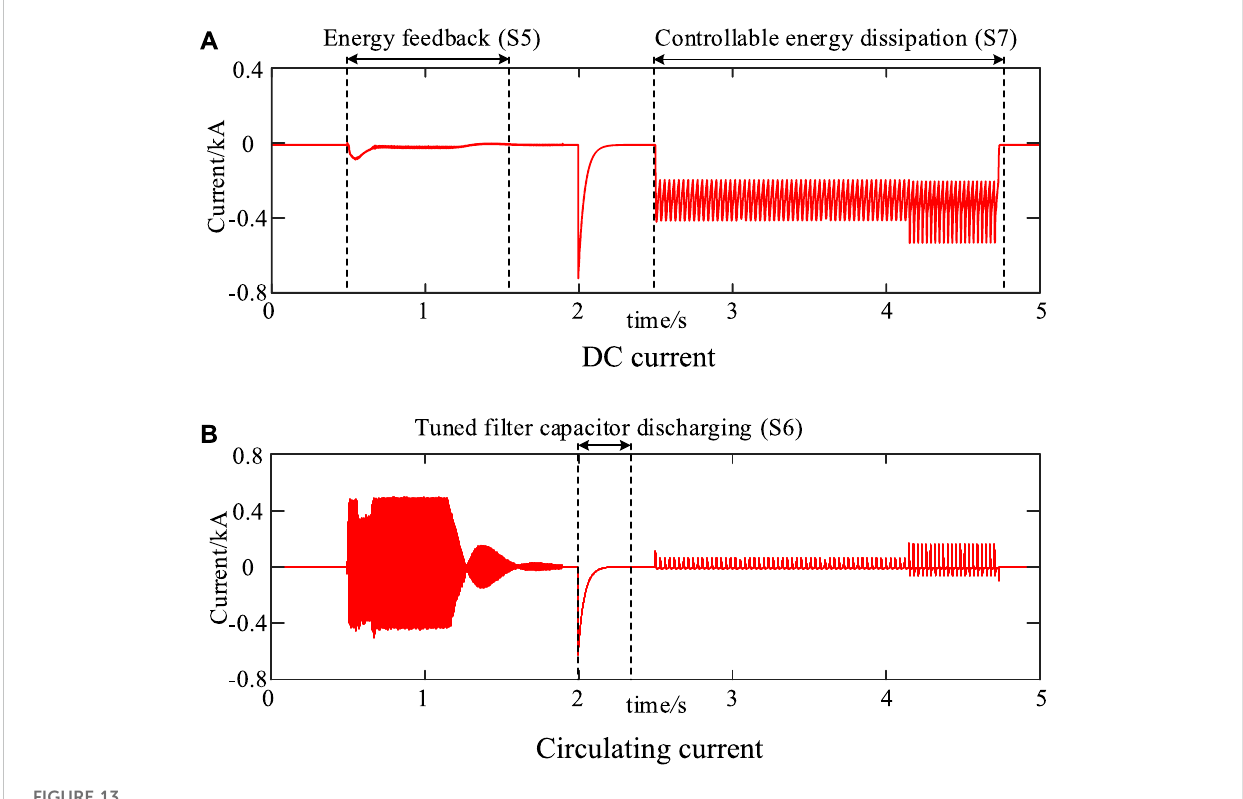
FIGURE 13 Simulation results of currents during the stop process. (A) DC current. (B) Circulating